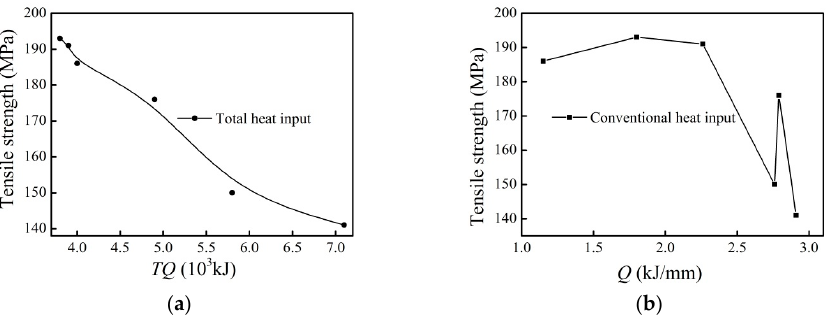
Figure 4. Effect of welding heat input on the transverse tensile strength of as-welded joints: ( a ) TQ (total heat input); ( b ) Q (heat input).